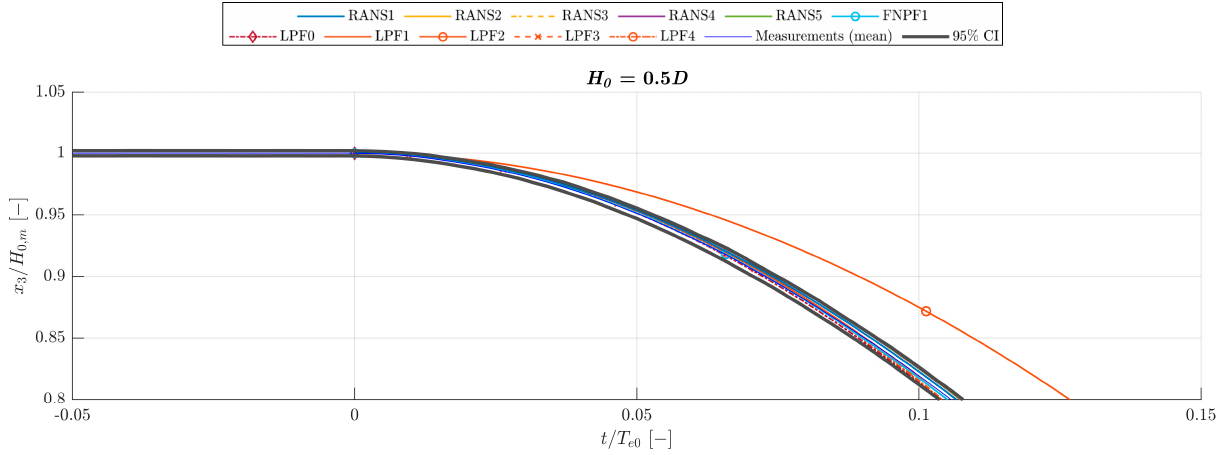
Figure 22. Comparison of physical and numerical test results at the initiation.